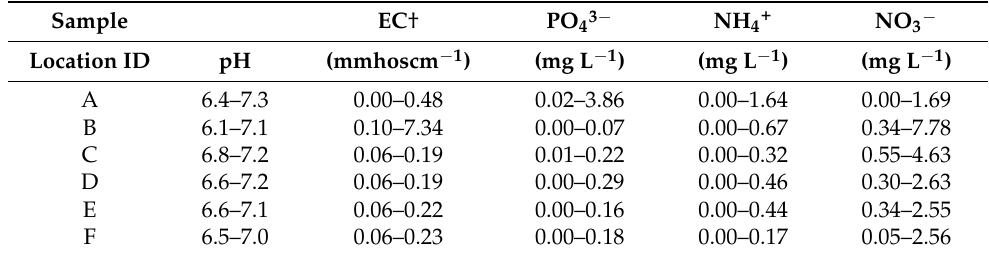
Table 3. Characteristics of the water samples ranging from the lowest to the highest concentration detected during 10 sampling dates throughout the